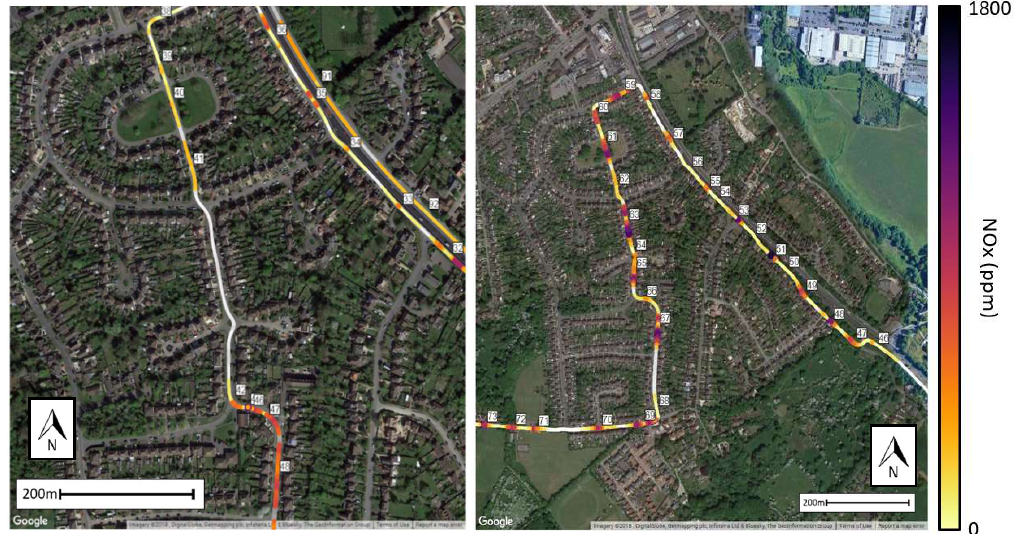
Figure 14. Comparison between the Euro V bus (L) and the Euro 5 car (R) going uphill.